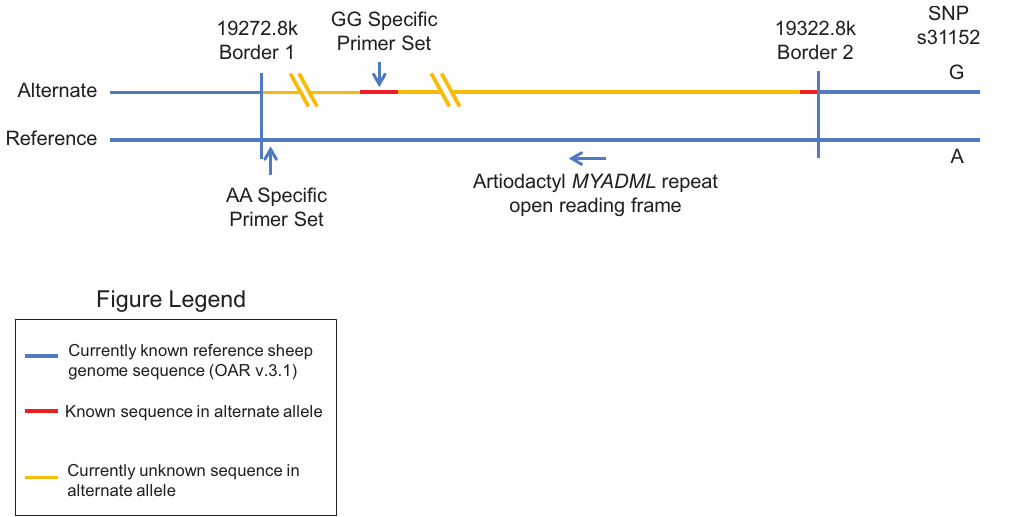
Figure 1. Artiodactyl MYADM -like Repeat Region of Alternate Alleles on Chromosome 18. A visual representation of what is known of the divergent artiodactyl MYADM -like repeat region of alternate alleles. The positions of allele-specific primer sets for each homozygote are specified.